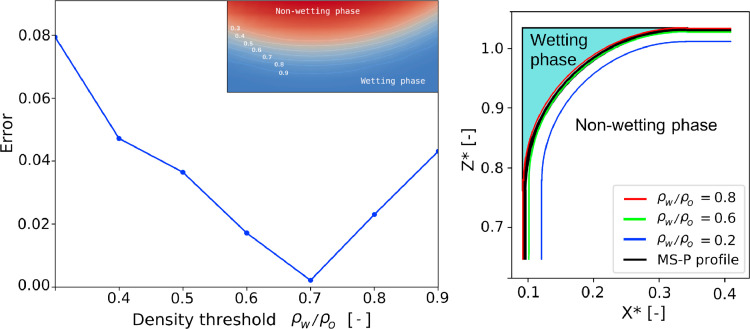
Difference in capillary pressure between LBM theoretical value deduced from meniscus geometry, as a function of the ρwcontour selected to define the interface. Sub-figure on the upper-right corner shows details of the density contours. On the right, interface profiles for different ρware superimposed. Both results correspond to a square cylinder.